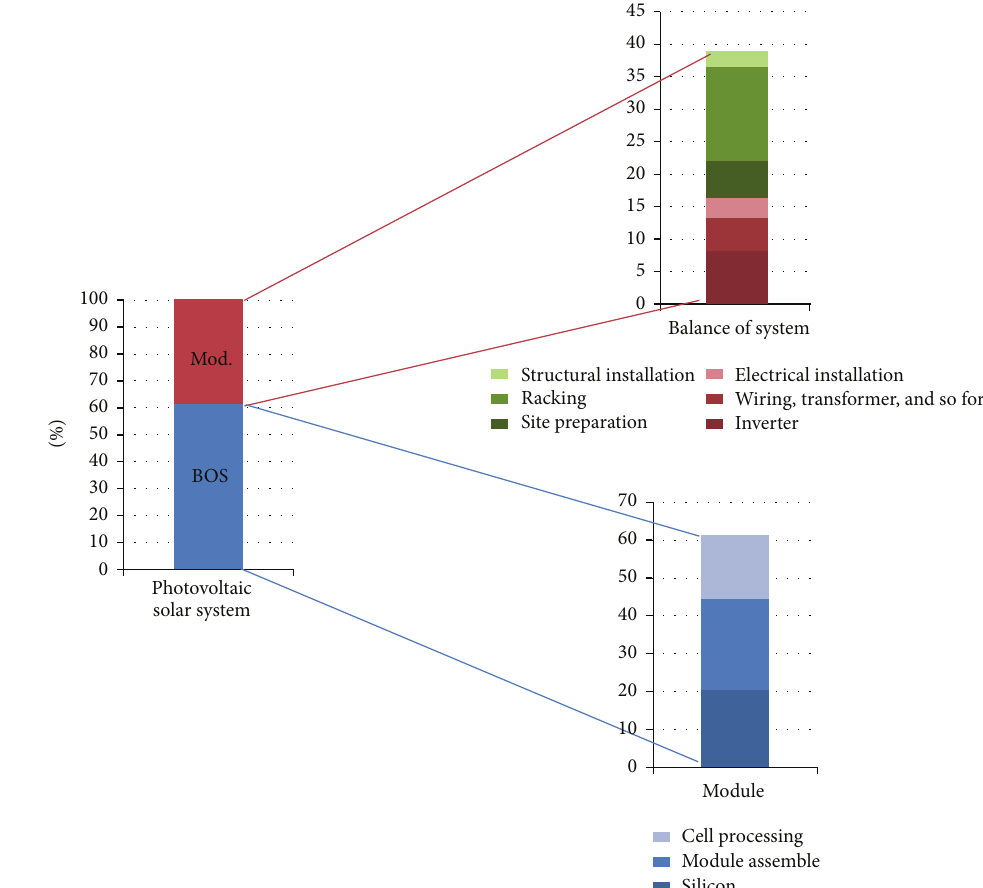
Figure 12: Price structure of photovoltaic systems for installations [4, 12].